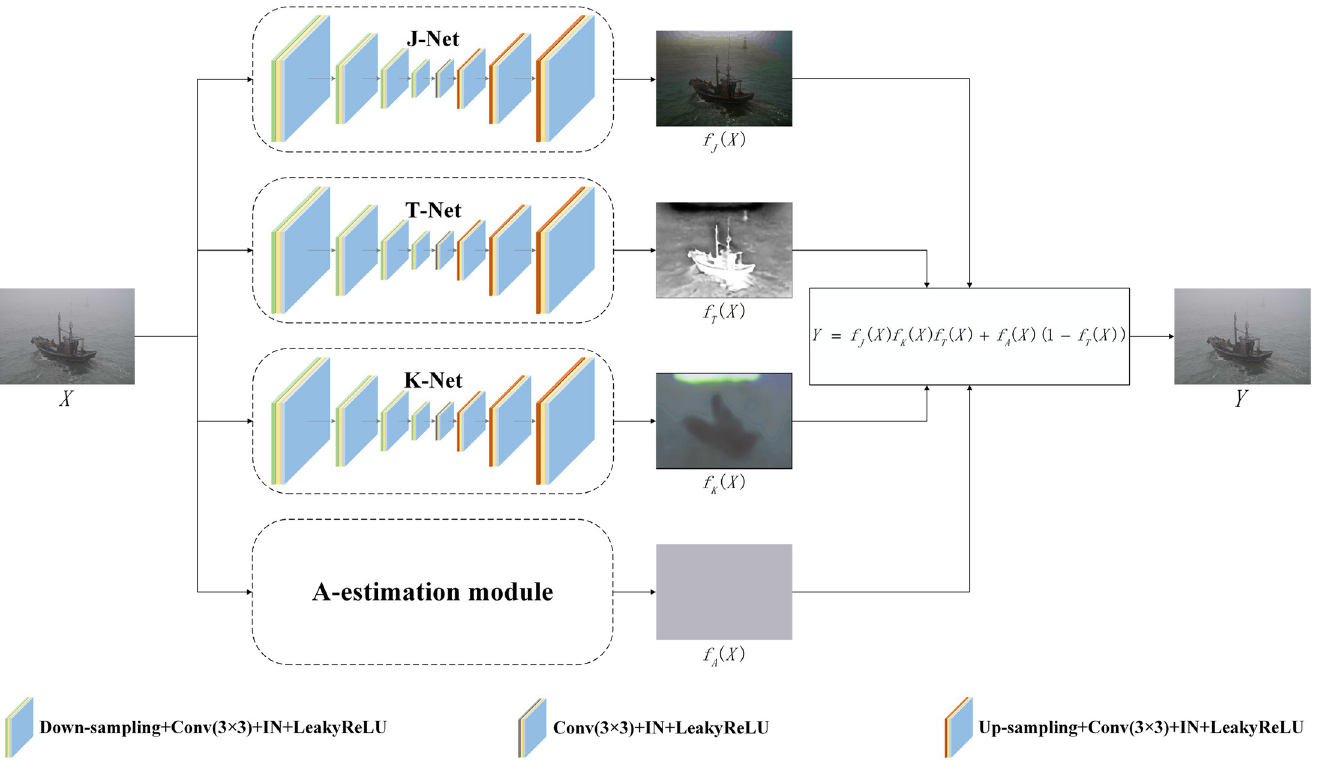
Fig 4. The proposed unsupervised dehazing network. In short, the unsupervised dehazing network consists of three unsupervised branches and a prior-based branch. The input hazy image is decomposed into four different layers by four branches, and then the four layers will be synthesized into hazy image according to the reconstructed atmospheric multiple scattering model.